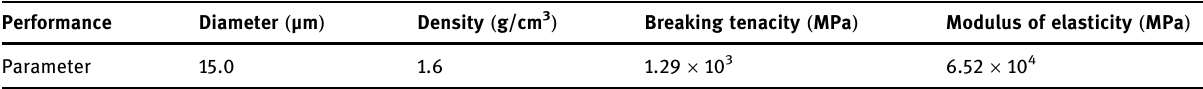
Table 2: Performance parameters of